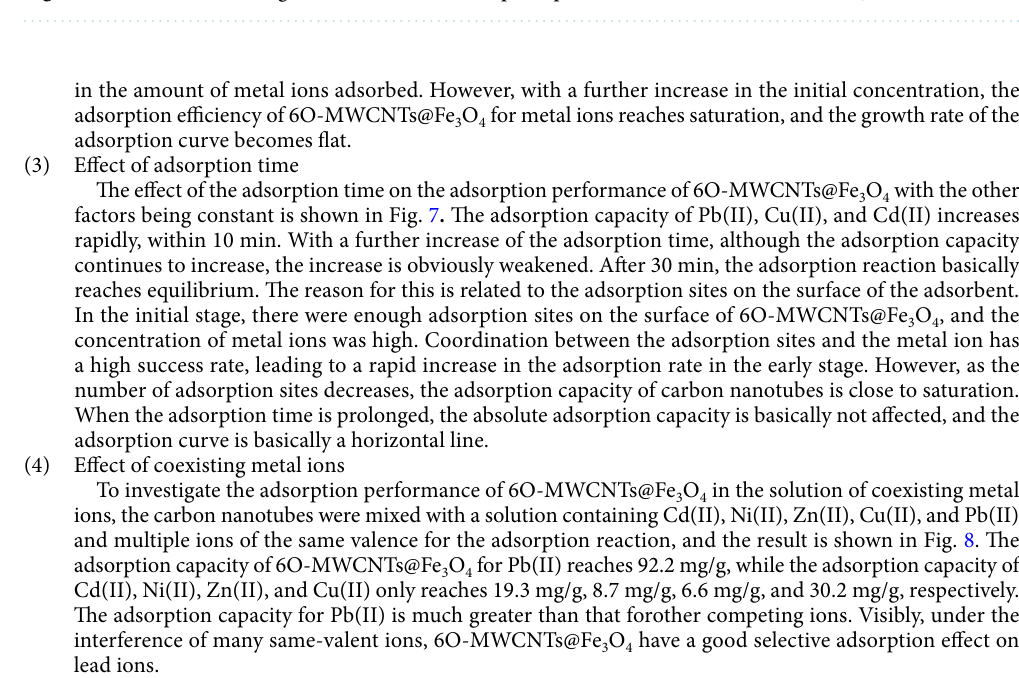
Figure 8. Effect of coexisting metal ions on the adsorption performance of 6O-MWCNTs@Fe 3 O 4